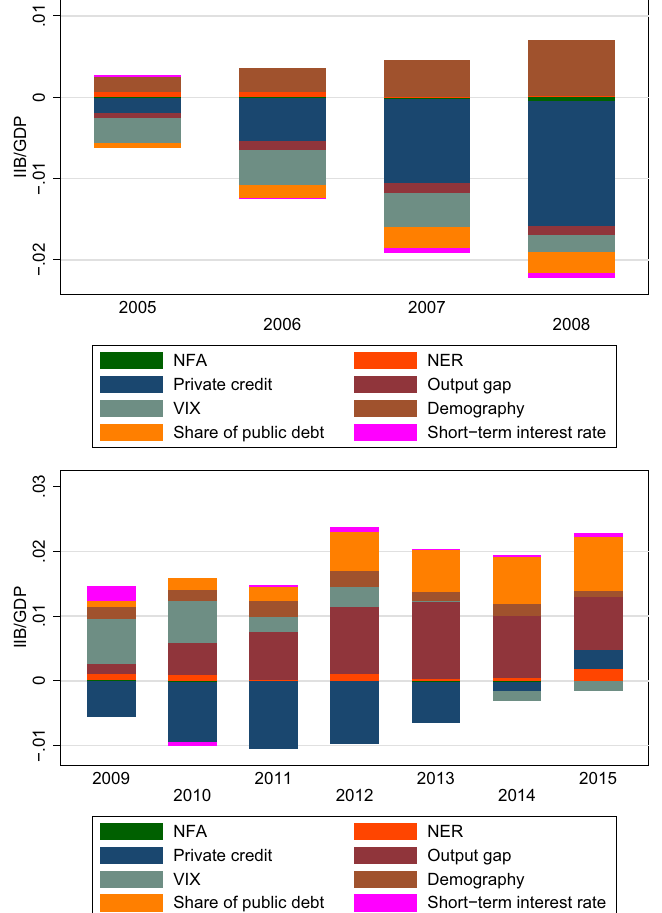
Fig. 9 Accumulated deterioration and correction of the Spanish income balance. Notes. This figure plots the detailed decomposition of the Spanish income balance with the contribution of each of the regressors included in Table 3. The left panel refers to accumulated deterioration over the expansion years 2005–2008, while the right panel refers to the post–2008 accumulated